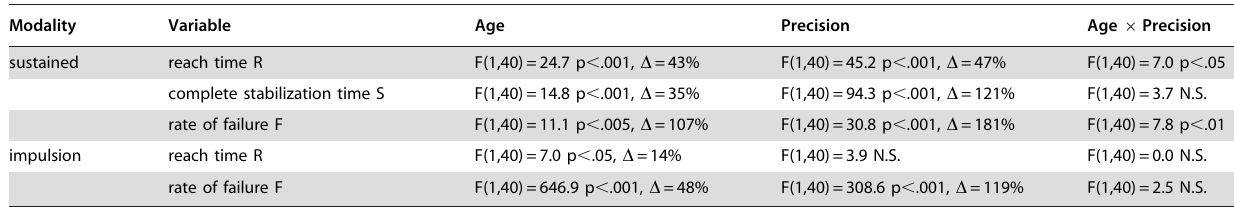
Table 1. Effects of Age and Precision on performance. .. ... .... ... ... .... ... ... .... ... ... .... ... ... .... ... ... .... ... ... .... ... ... .... ... ... .... ... ... .... ... ... .... ... ... .... ... ... .... ... ... .... ... ...